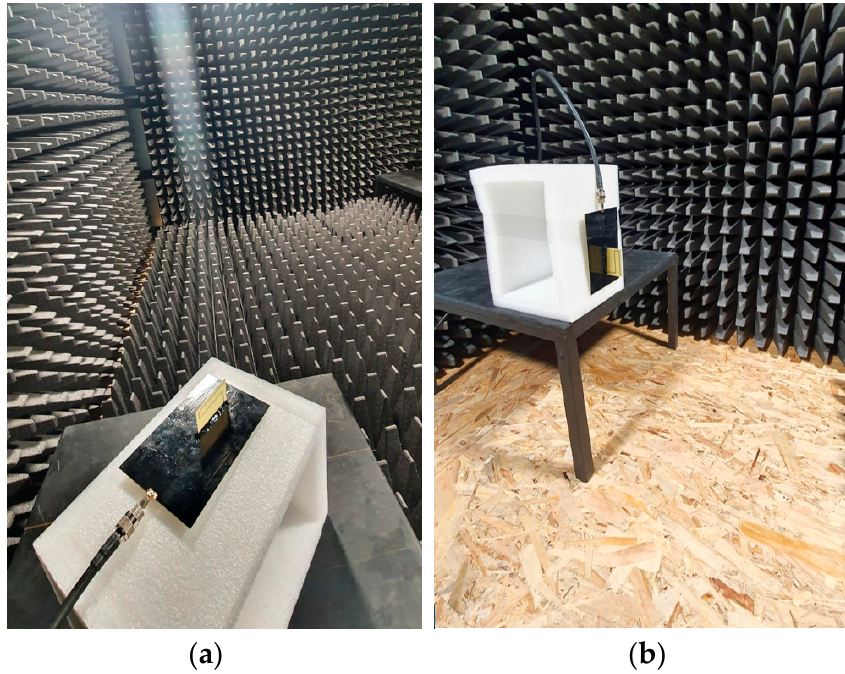
Figure 21. Measuring configuration for the input reflection coefficient: ( a ) with absorbers on the floor; ( b ) without absorbers on the floor.